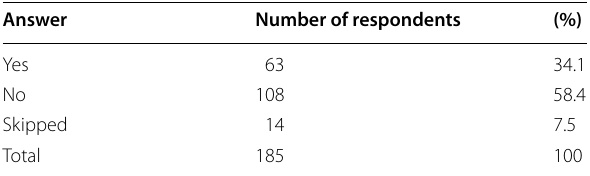
Table 7 Experience of 185 respondents with AI-based algorithms for clinical diagnostic interpretive tasks: Was the diagnostic accuracy (ROC curves) supervised on a regular basis in comparison with the radiologist’s diagnosis?